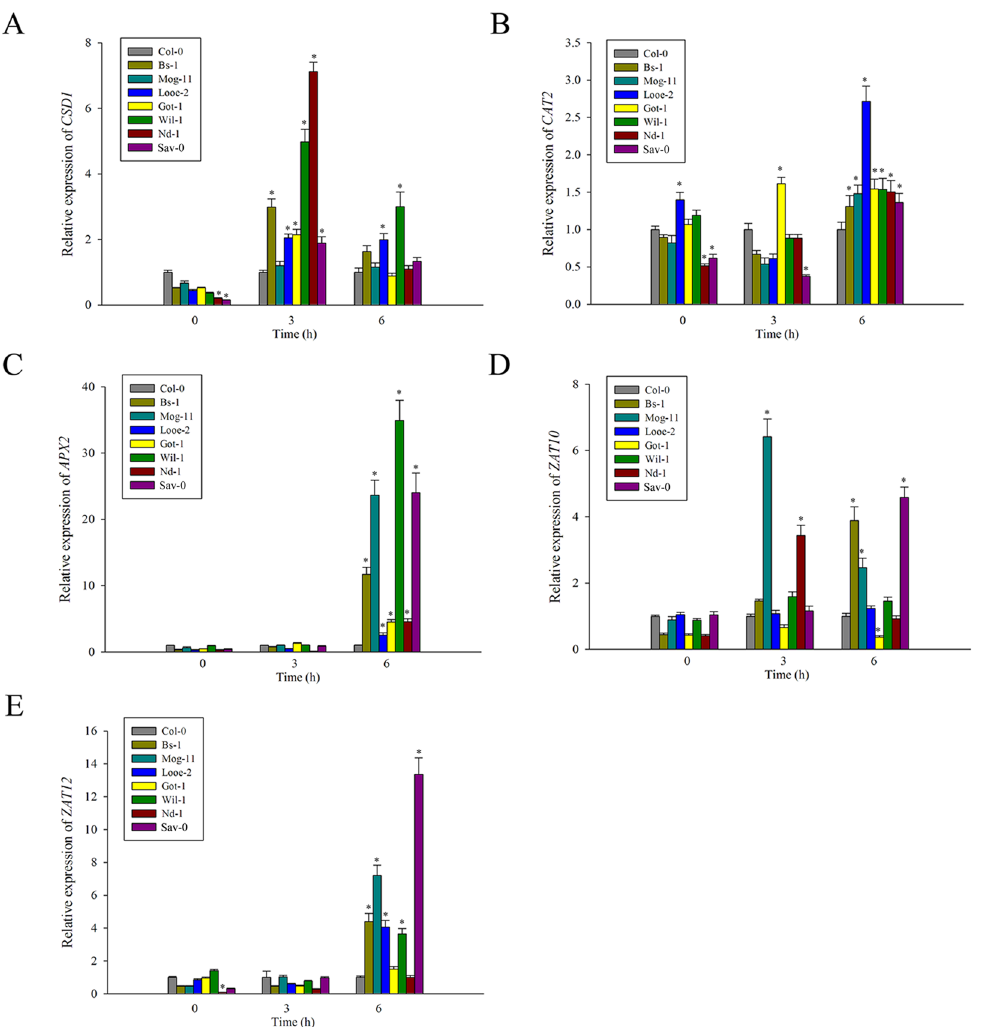
Fig 8. Expression analysis of genes related to ROS metabolism by qRT-PCR. The transcript levels of (A) CSD1 , (B) CAT2 , (C) APX2 , (D) ZAT10 and (E) ZAT12 in Col-0 and the selected accessions exposed to 100 mM NaCl for 0, 3 and 6 h. Significant differences from Col-0 accession at the same time point are indicated by * ( P <